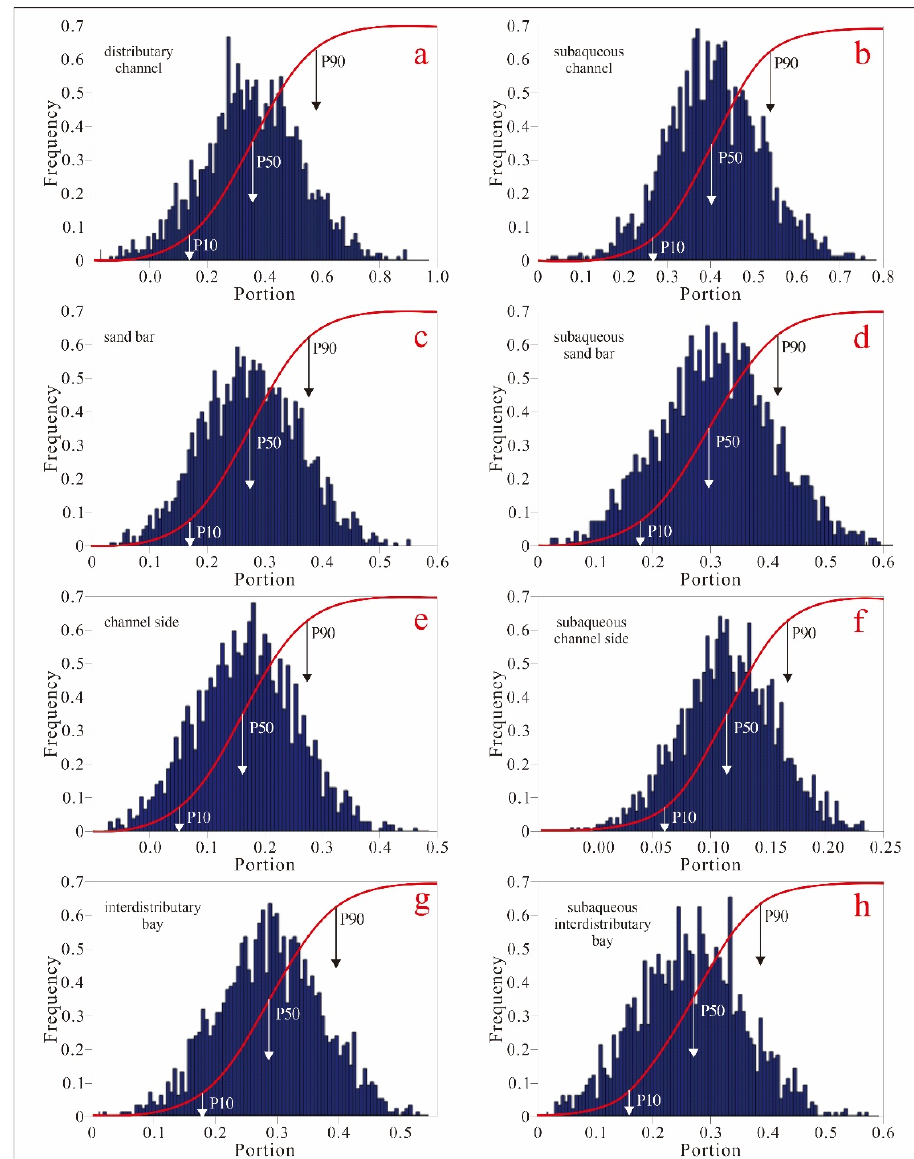
Figure 8. Probability distributions of architectural elements in all wells showing best estimate (P50), high estimate (P10), and low estimate (P90). The delta plain elements are on the left and the corresponding subaqueous delta front elments are on the right. ( a ): distributary channel; ( b ): subaqueous channel; ( c ): sand bar; ( d ): subaqueous sand bar; ( e ): channel side; ( f ): subaqueous channel side; ( g ): interdistributary bay; ( h ): subaqueous interdistributar bay.